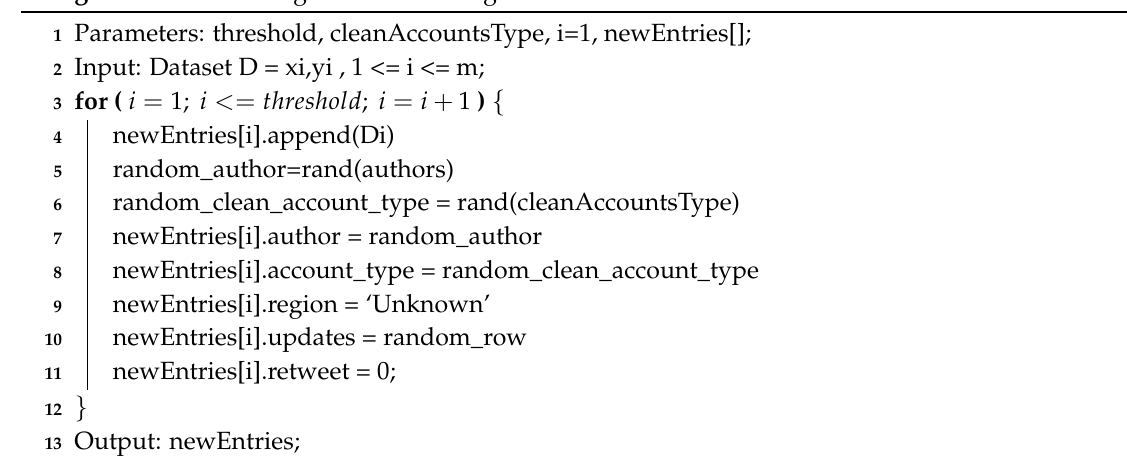
Algorithm 2: Poisoning New Entries